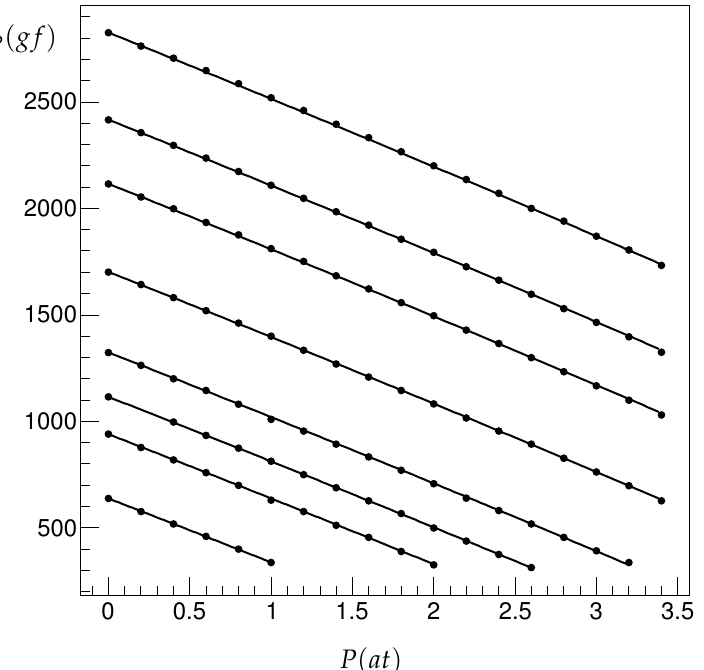
Figure 2. The 9.8-mm straw effective tension T P versus the overpressure P for different initial tensions T P ( 0 ) . Circles, measurements; solid lines, fit by Equation